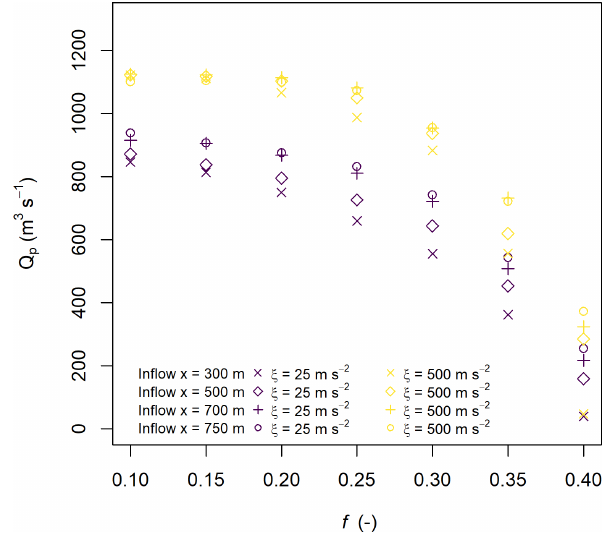
Figure A3. Sensitivity analysis for peak discharge at x = 1000m for different inflow